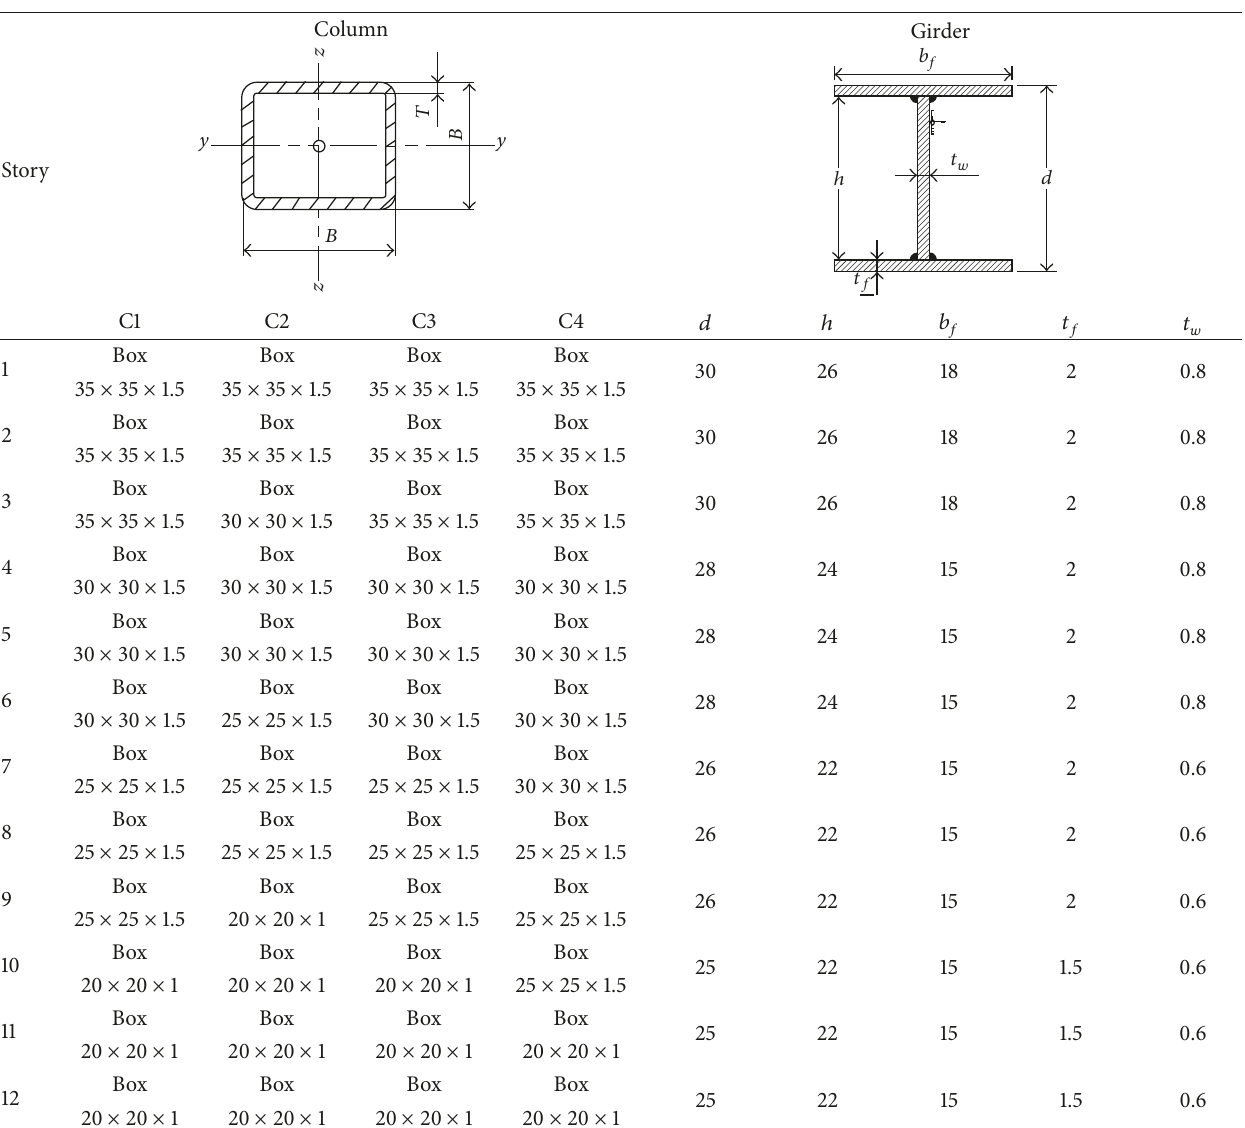
Table 10: Sections for the 12-story steel